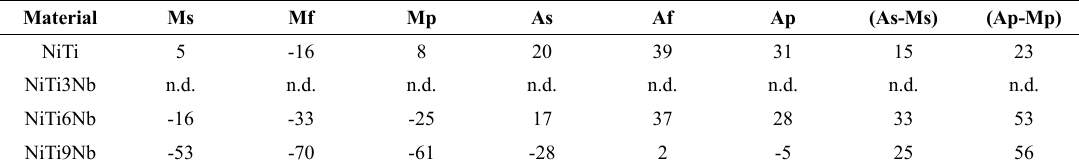
Figure 3. SEM micrographs of the alloys (a) NiTi3Nb, (b) NiTi6Nb and (c) NiTi9Nb, indicating the points chosen for the EDS analyses: (1) matrix, (2) eutectic phase, (3) β-Nb particles. Table 3. Transformation temperatures (°C) obtained by the DSC